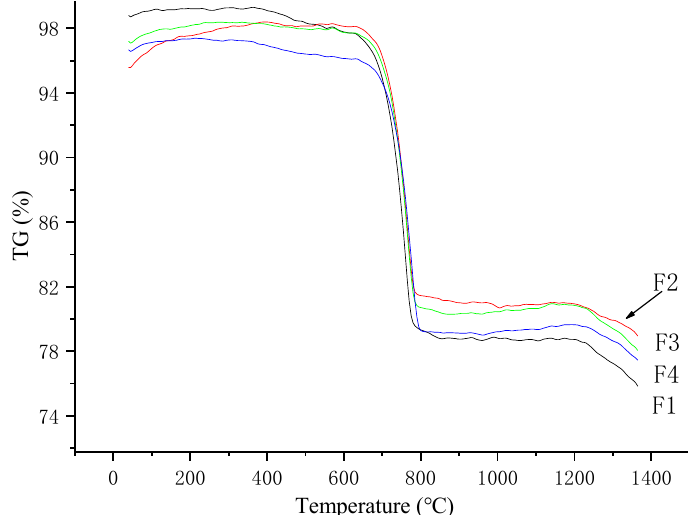
Figure 1. DSC curves of raw materials.